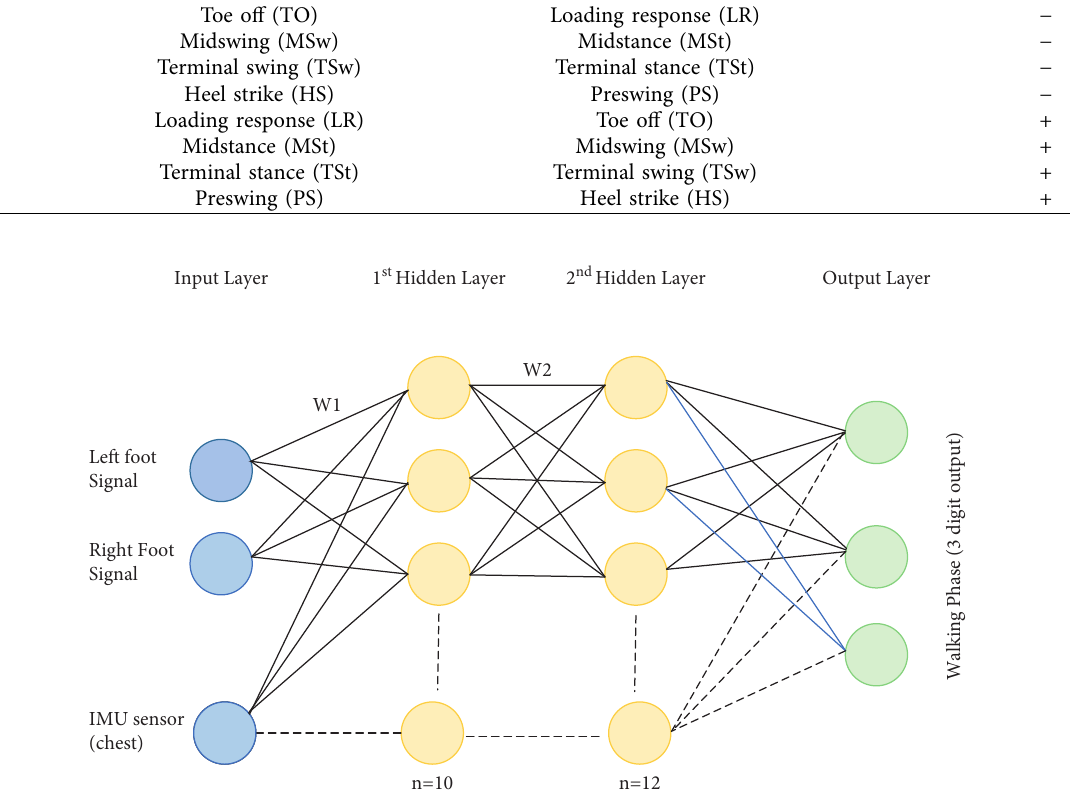
Figure 4: Classification architecture of the proposed neural